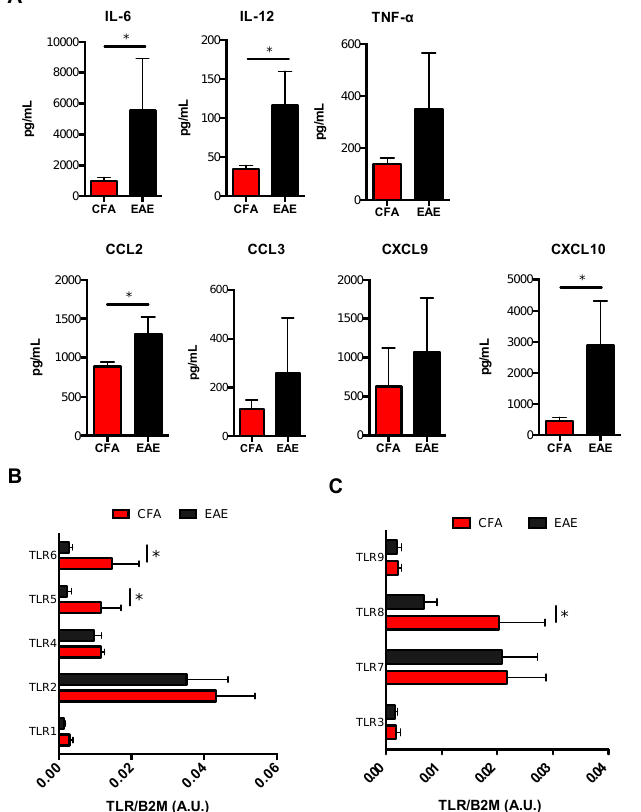
Figure 4. Expression of cytokines/chemokines and TLRs in M1 obtained from CFA and EAE mice. ( A ) ELISA of cytokines (IL- 1β, IL -6, IL-12, TNF- α, IL -10) and chemokines (CCL2, CCL3, CXCL9, and CXCL10) in supernatants of M1 macrophages. Data are reported as pg/mL and represent 10 inde- pendent experiments means ± SEM. * p < 0.05 ( B , C ) qRT-PCR analysis of the expression of both bacterial (TLR1, TLR2, TLR4, TLR5, TLR6) ( B ) and viral (TLR3, TLR7, TLR8, TLR9) ( C ) Toll-like receptors in M1 macrophages. Cycling threshold values are normalized to those of mRNA encoding β2 -microglobulin, and data are normalized to the maximum value obtained for each donor. Data are expressed as arbitrary units (A.U.) and are shown as means ± SEM of eight independent exper- iments each in duplicate. * p < 0.05.